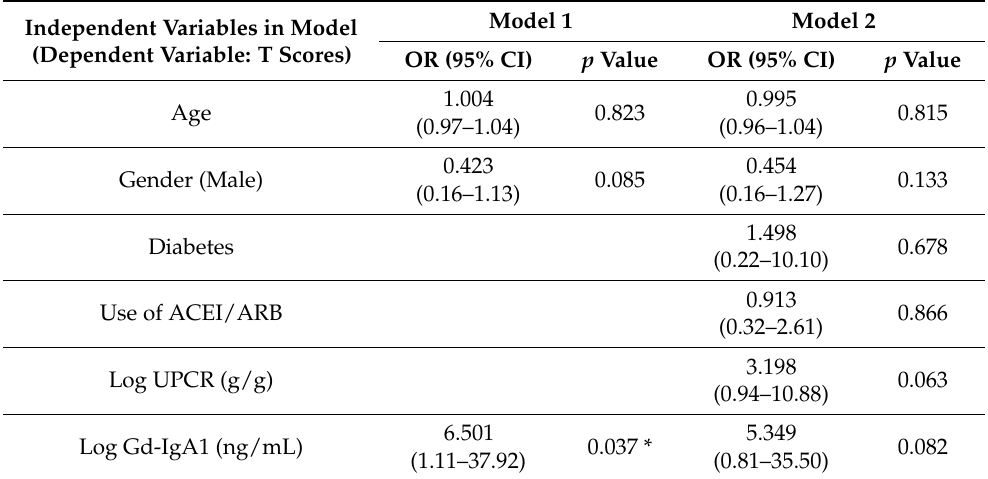
Table 5. Associations between the plasma Gd-IgA1 level with tubular atrophy/interstitial fibrosis (the Oxford T